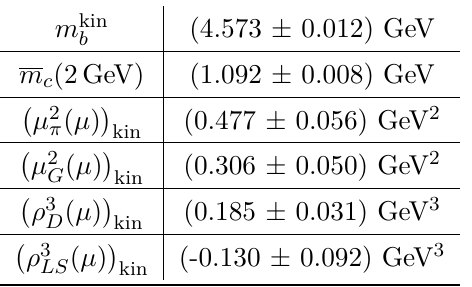
Table 1. Numerical inputs from [1]. The HQE parameters and the b -quark mass are given in the kinetic scheme at µ = 1